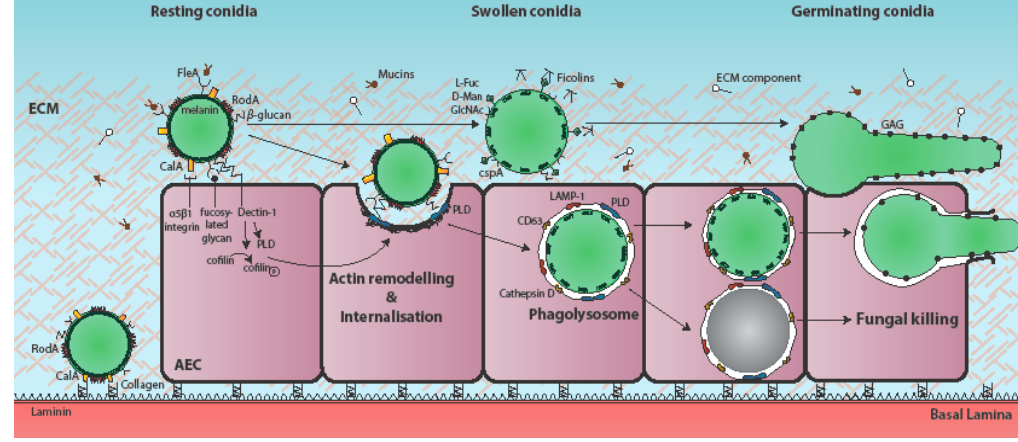
Figure 1. Temporal and mechanistic basis of A. fumigatus attachment to, and uptake by, the respiratory epithelium. Respiratory aspergilloses commence with interaction of inhaled